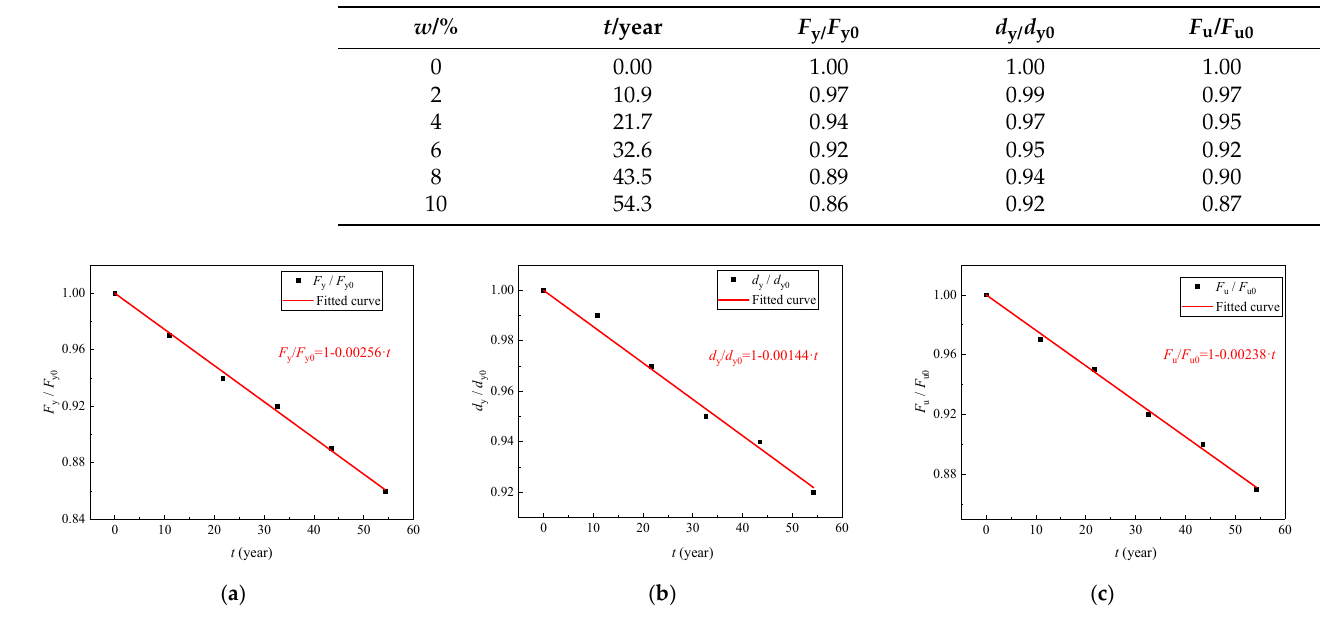
Figure 21. Fitting results against the service life, t , in years: ( a ) F y/ F y0 ; ( b ) d y/ d y0 ; ( c ) F u / F u0. Comparing the slopes of the three curves, it is obvious that the yield load of the joint decreases fast, while the changes in the yield displacement are small, which indicates that corrosion has a great influence on the elastic bearing capacity of the joint. The least squares method was adopted to establish the quantitative relationships between the mechanical properties and service time ( t ). The expressions are shown as